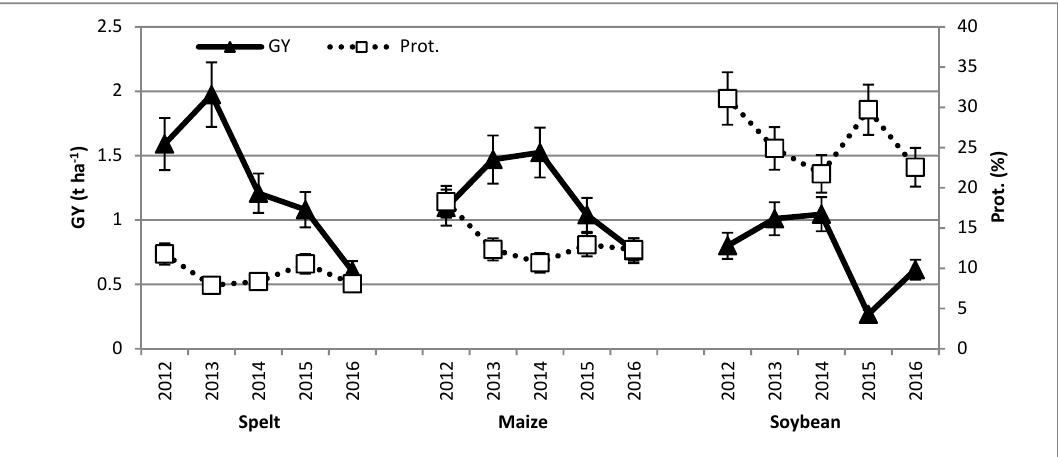
Figure 6. The variation of grain yield (GY) and protein content in grain of organically produced spelt, maize, and soybean (bars represent SD values).